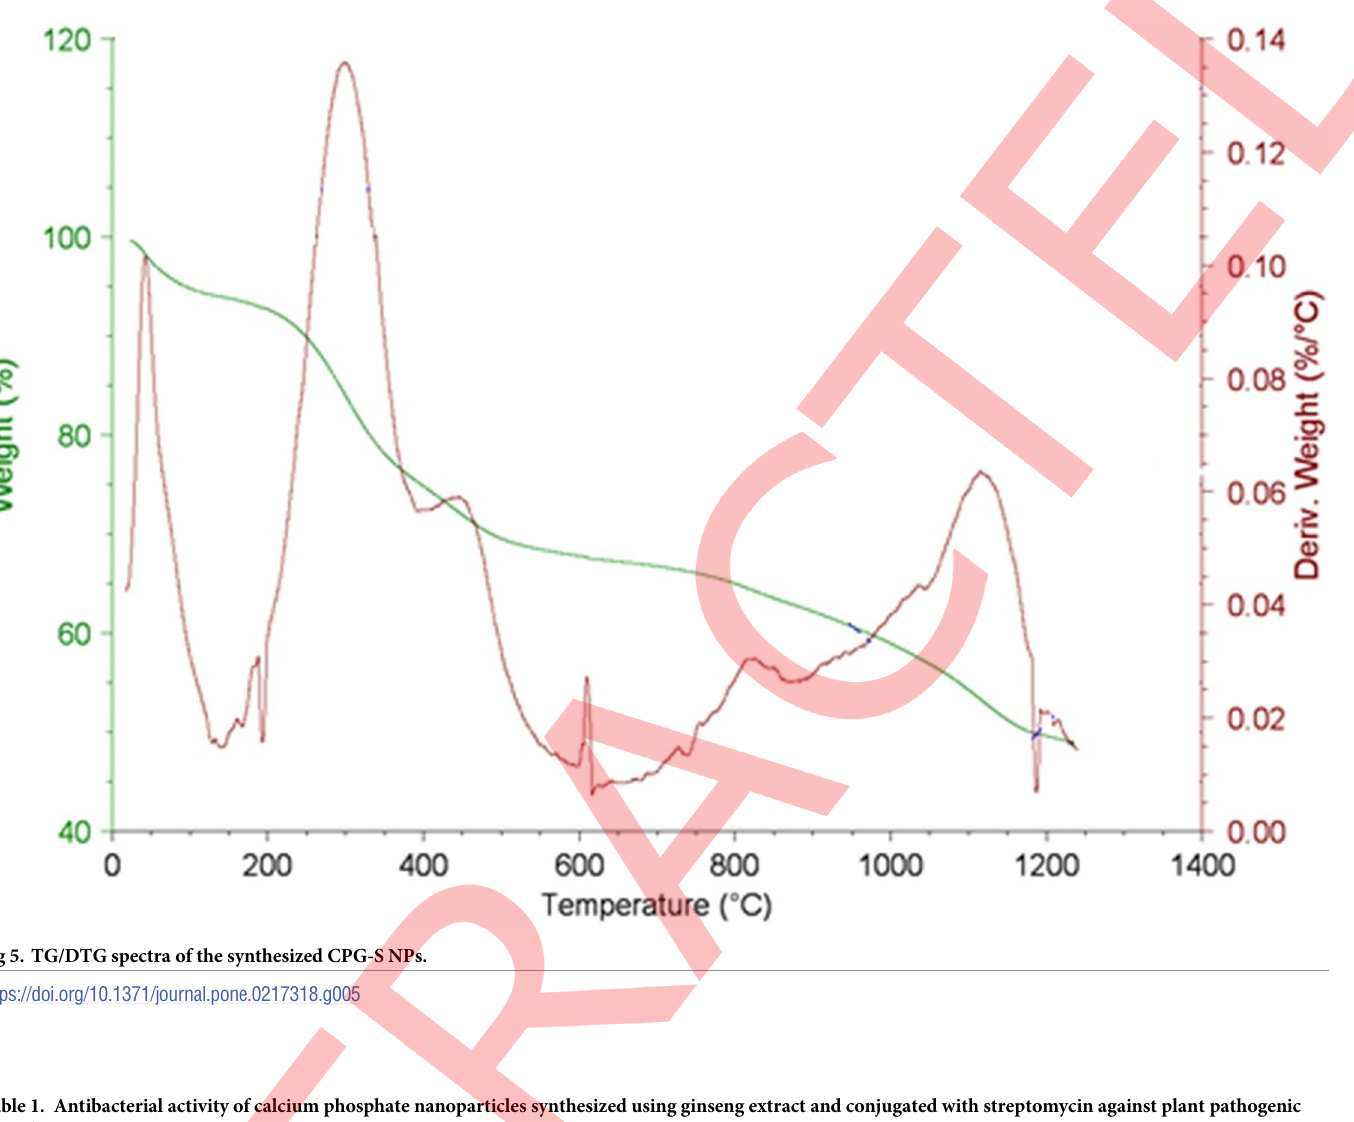
Table 1. Antibacterial activity of calcium phosphate nanoparticles synthesized using ginseng extract and conjugated with streptomycin against plant pathogenic bacteria. Plant